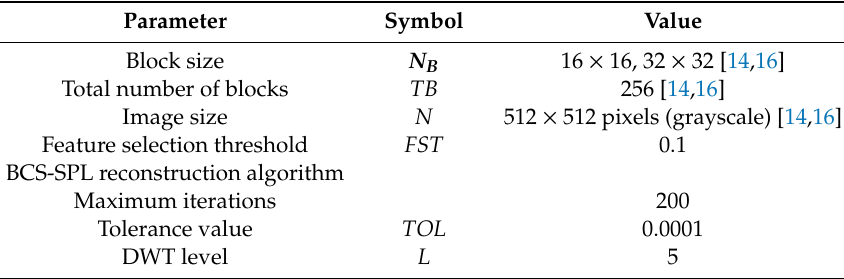
Table 5. Simulation